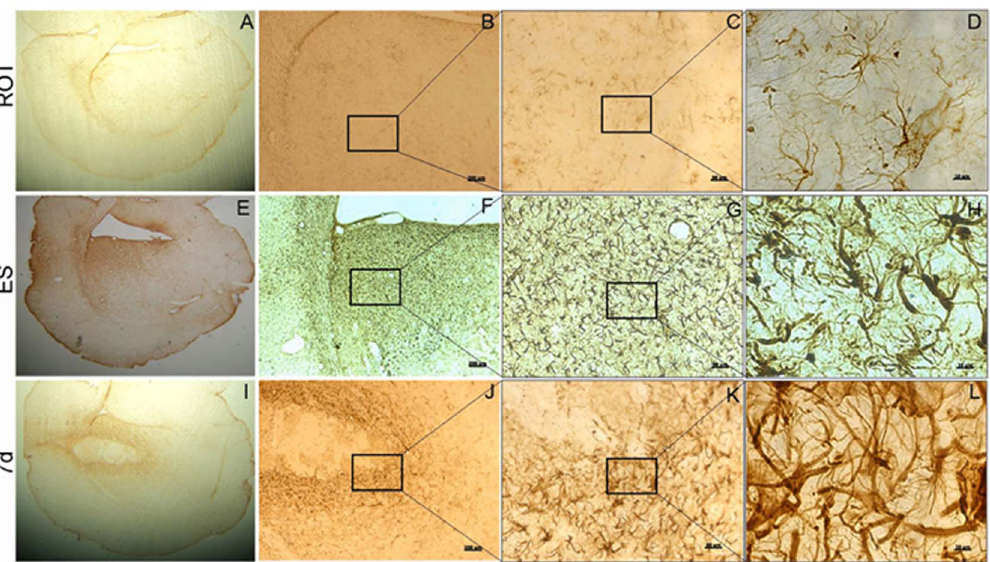
Figure 8. Astrocytosis in differentiated cells implanted striatum. Striata, ipsilateral to the side of rotenone infusion were grafted with vehicle without any cells (ROT; A–D), embryonic stem cells undifferentiated (ES; E–H) or 7 days differentiated cells (7 d; I–L), were stained for the astrocyte marker glial fibrillary acidic protein (GFAP) immunoreactivity. Increased immunostaining for GFAP is seen only in the ES and 7 d cells grafted striata. A,E and I are low magnification images, whereas D,H,L and C,G,K are magnified images from the ‘boxes’ each from the previous figures, as marked in the same lane. A,E,I are 5 6 magnification, whereas scale bars in B,F, and J are 200 m m; in C,G, and K are 50 m m, and D,H, and L are 10 m m.